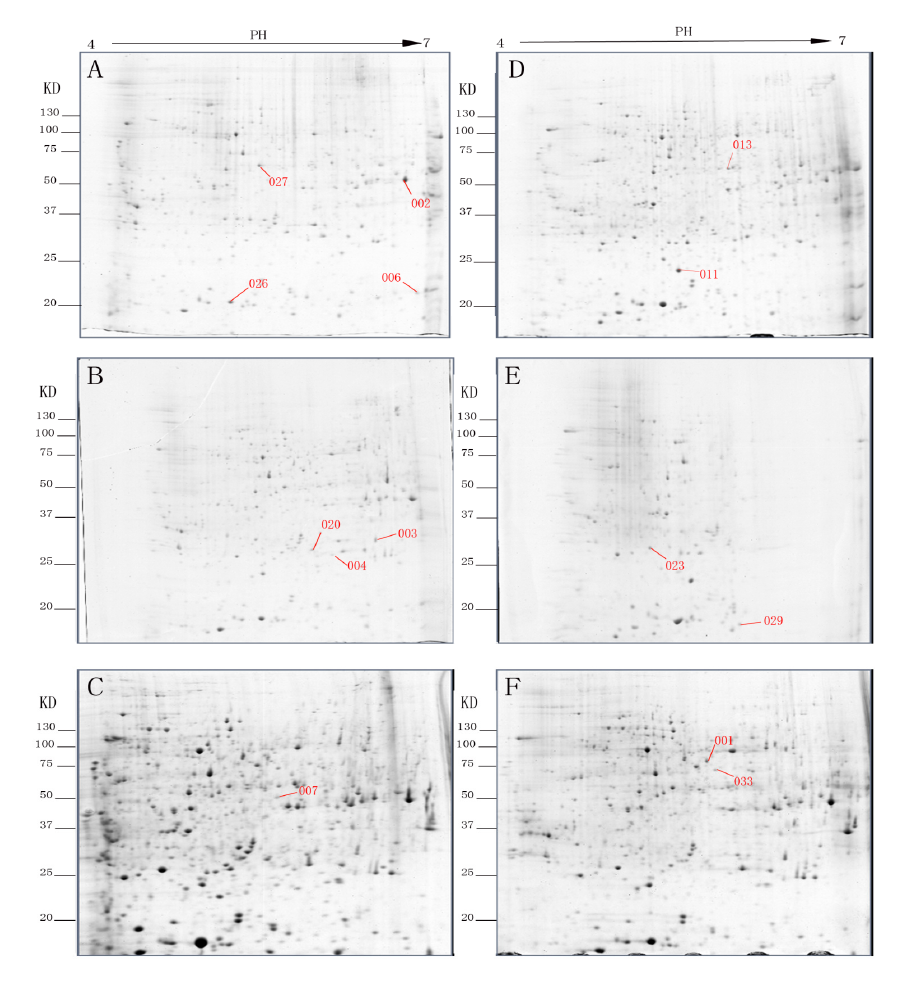
Figure 1. Representative two-dimensional electrophoresis (2-DE) gels of rooting of etiolated juvenile tetraploid Robinia pseudoacacia branches after ( A ) day 0; ( B ) day 3; and ( C ) day 9. Representative 2-DE gels of rooting of non-etiolated juvenile tetraploid Robinia pseudoacacia branches after ( D ) day 0; ( E ) day 3; and ( F ) day